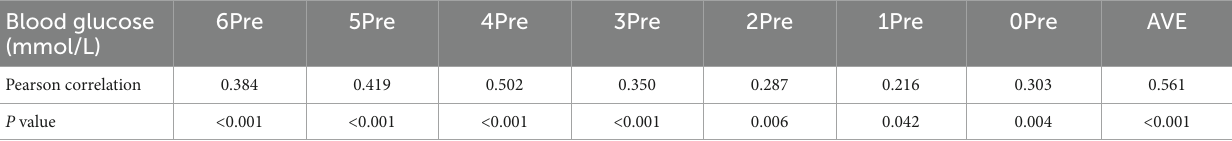
TABLE 1 Correlation analysis between the cerebrospinal fluid glucose level and blood glucose level at each time point before lumbar puncture in patients in the group with normal glucose metabolism. Blood glucose (mmol/L)